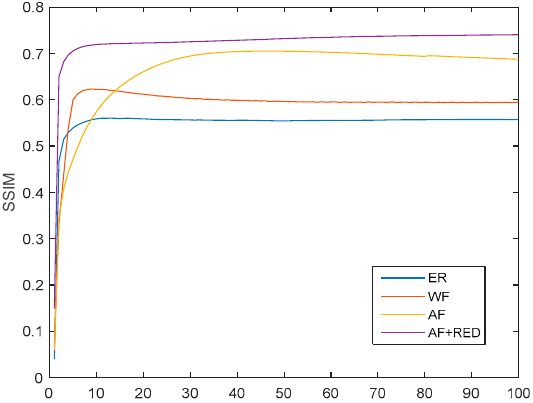
Figure 13. Quantitative comparison of the reconstruction results using different algorithms.